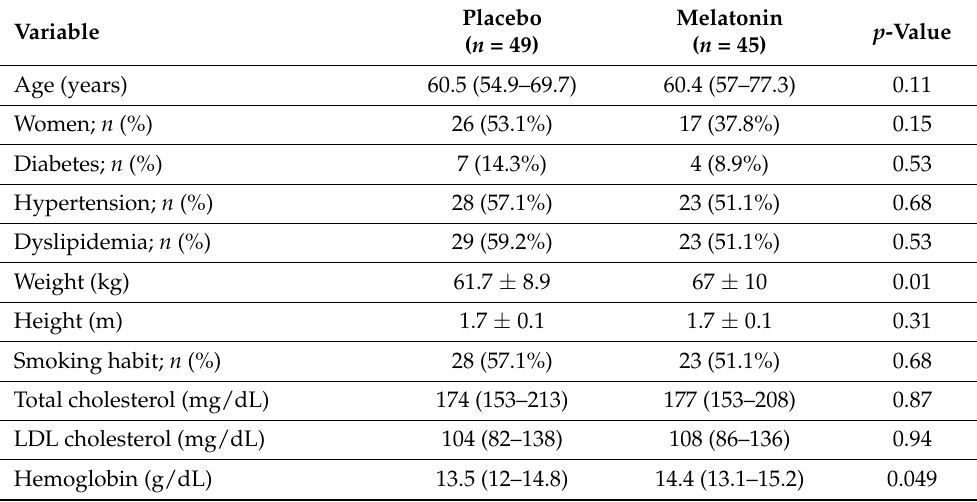
Table 1. Demographic, clinical, and procedural patient characteristics per randomized group.